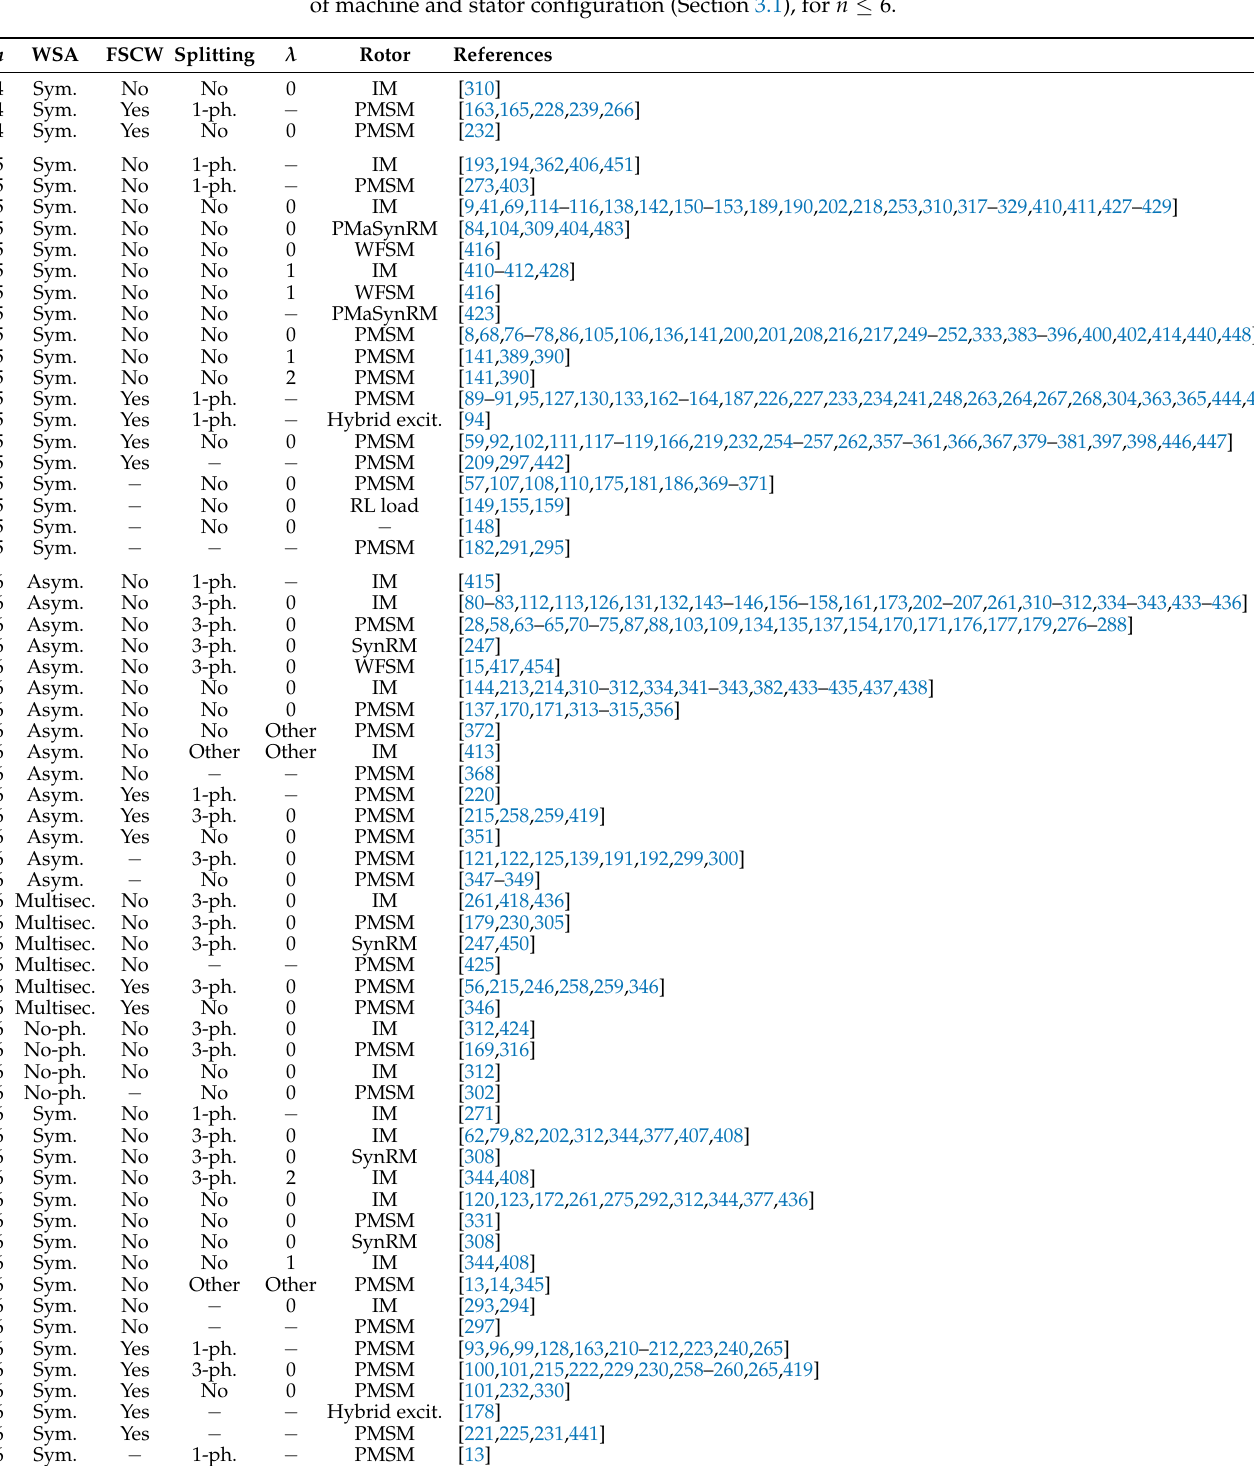
Table 4. Classification of references about fault tolerance in multiphase drives according to the type of machine and stator configuration (Section 3.1), for n ≤